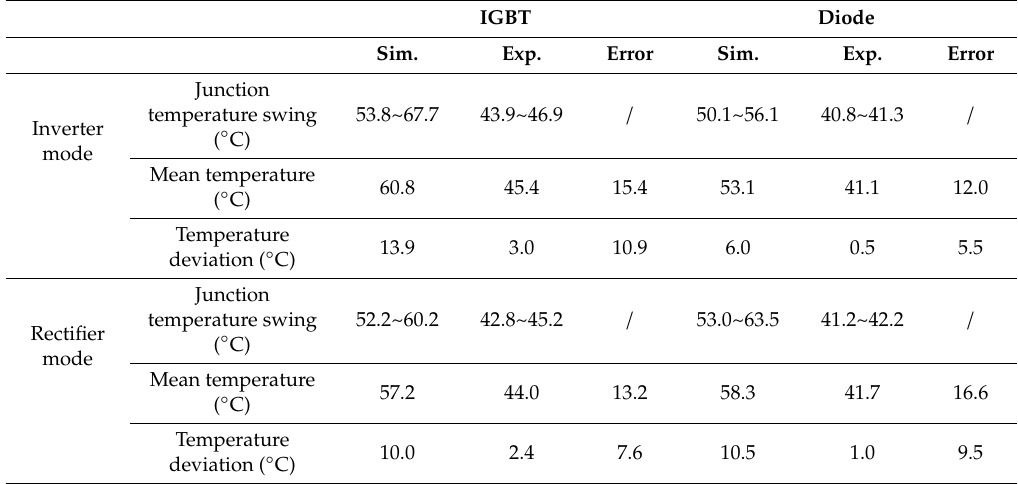
Figure 11. Experimental results in terms of the loading current and junction temperature of power semiconductors. ( a ) Inverter mode. ( b ) Rectifier mode. Table 3. Thermal Stress Comparison between Simulation (Sim.) and Experiment